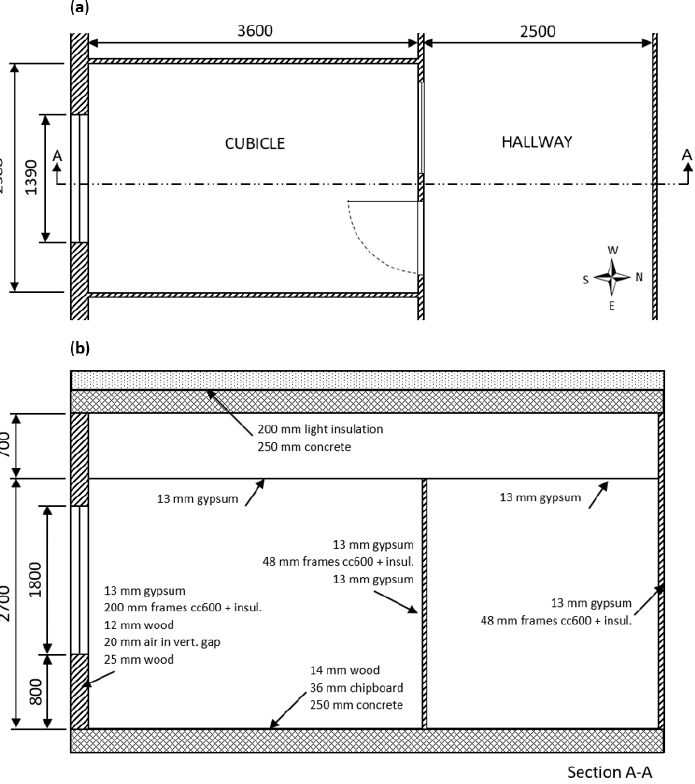
Figure 5. Layout of a cubicle and the adjacent hallway and technical space. The design is repeated for all neighbouring cubicles. Dimensions are in mm. ( a ) Plan view. ( b ) Section